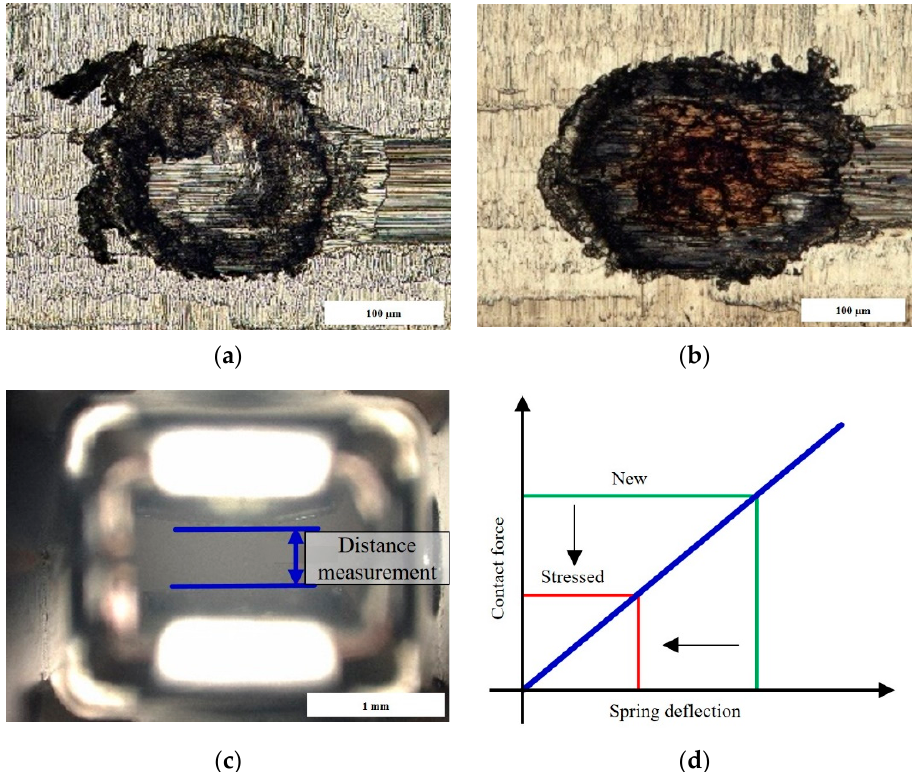
Figure 1. Light microscopic investigations of electrical connectors stressed by fretting corrosion tests: ( a ) Wear on the tin layer; ( b ) Abrasion of the tin layer; ( c ) Measurement of the contact opening dimension for the evaluation of mechanical stress relaxation; ( d ) Contact force via spring deflection for the used electrical contact.